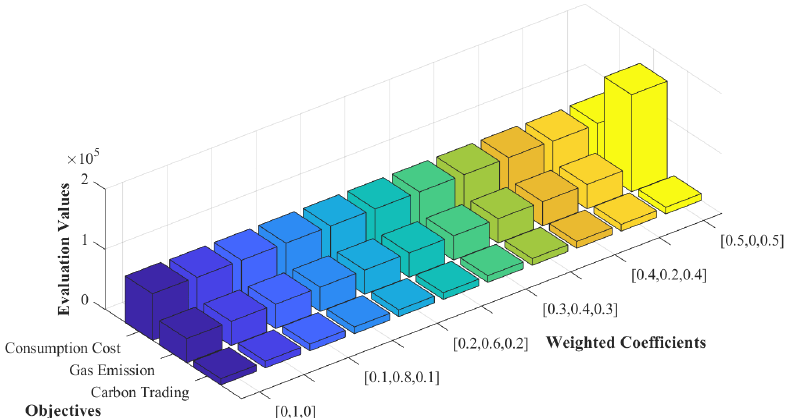
Figure 6. Evaluation values under dynamic-weighted coefficient sets.